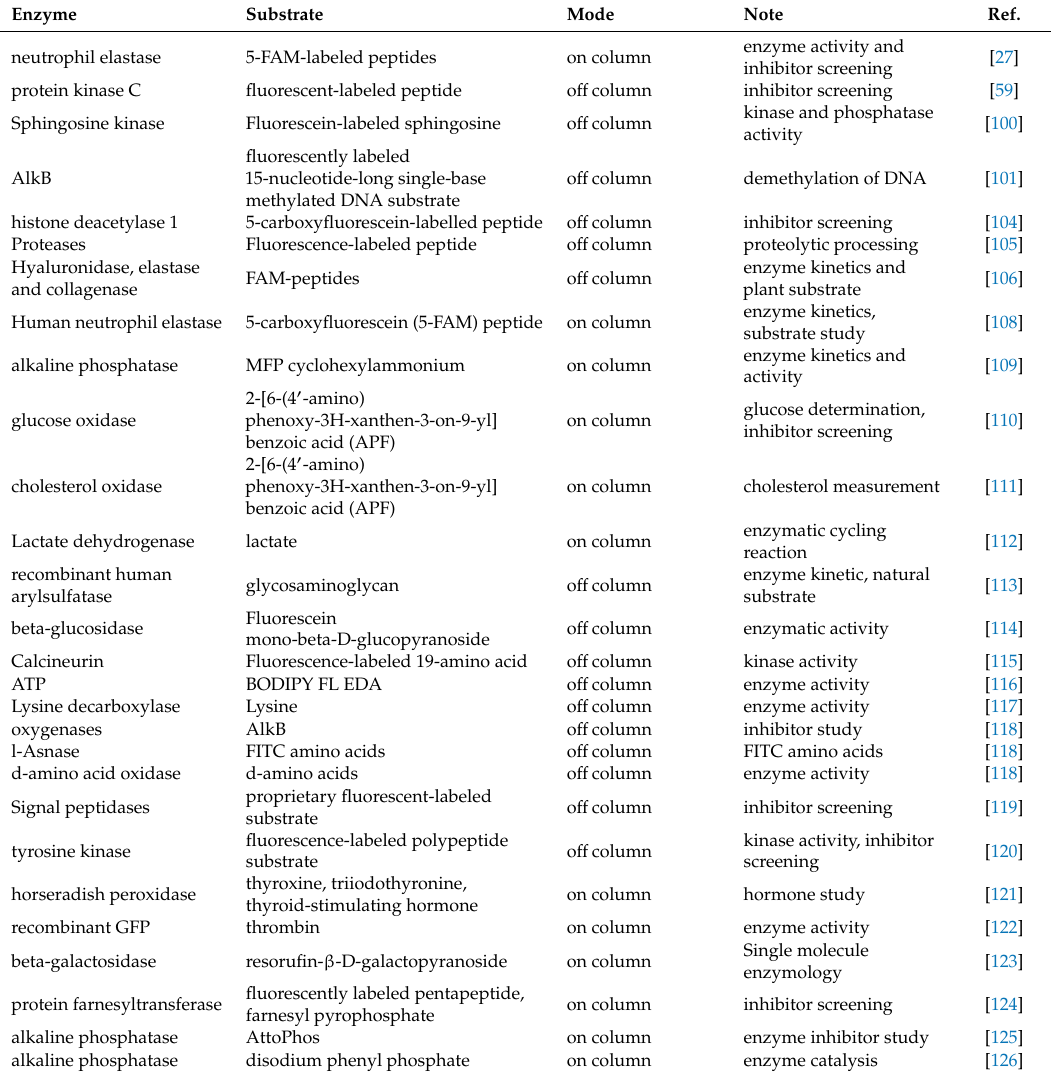
Table 2. Recent CE-LIF enzyme